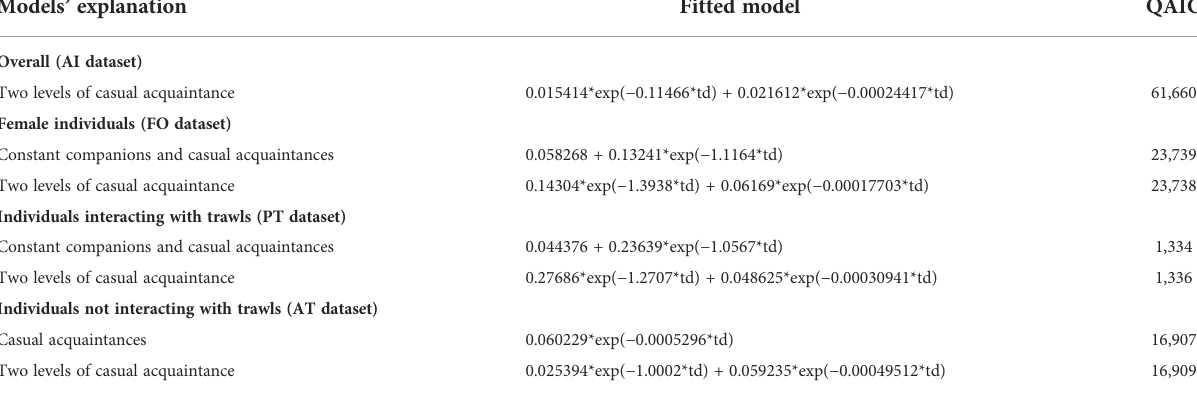
TABLE 3 Exponential decay models fi tted to the standardized lagged association rate (SLAR) among bottlenose dolphin individuals at the Tiber River